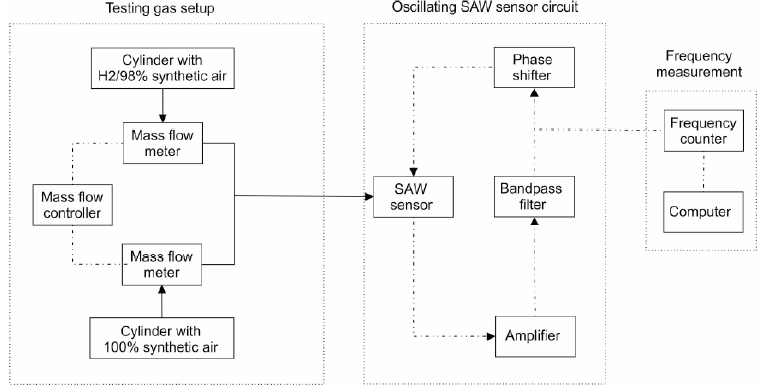
Figure 1. Experimental setup for surface acoustic wave (SAW) sensor frequency shift measurements for hydrogen detection [29]